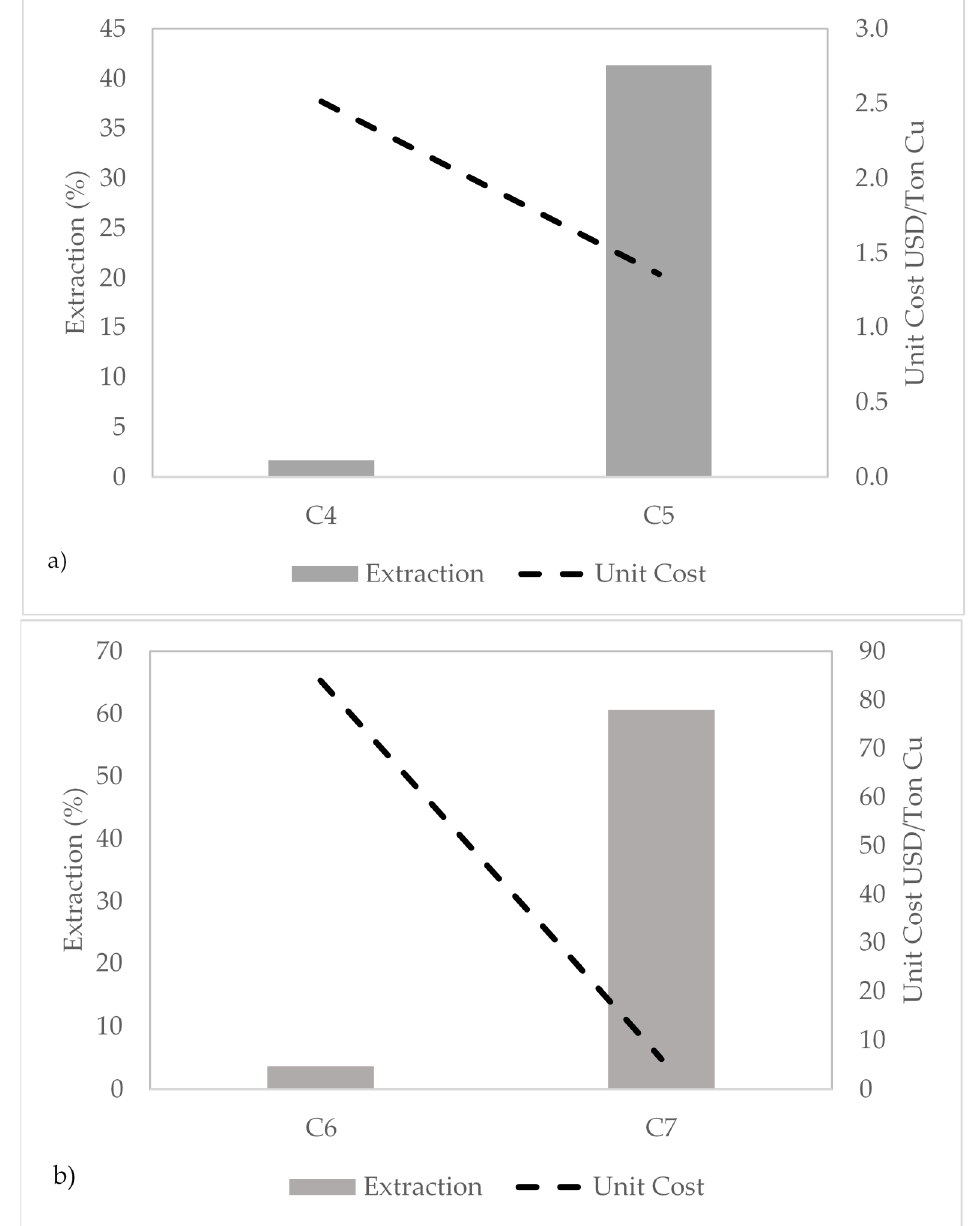
Figure 8. Analysis of copper extraction and unit cost of experiments. ( a ) Leaching solution contained only sulfuric acid. ( b ) Leaching solution contained the highest concentration of reagents.